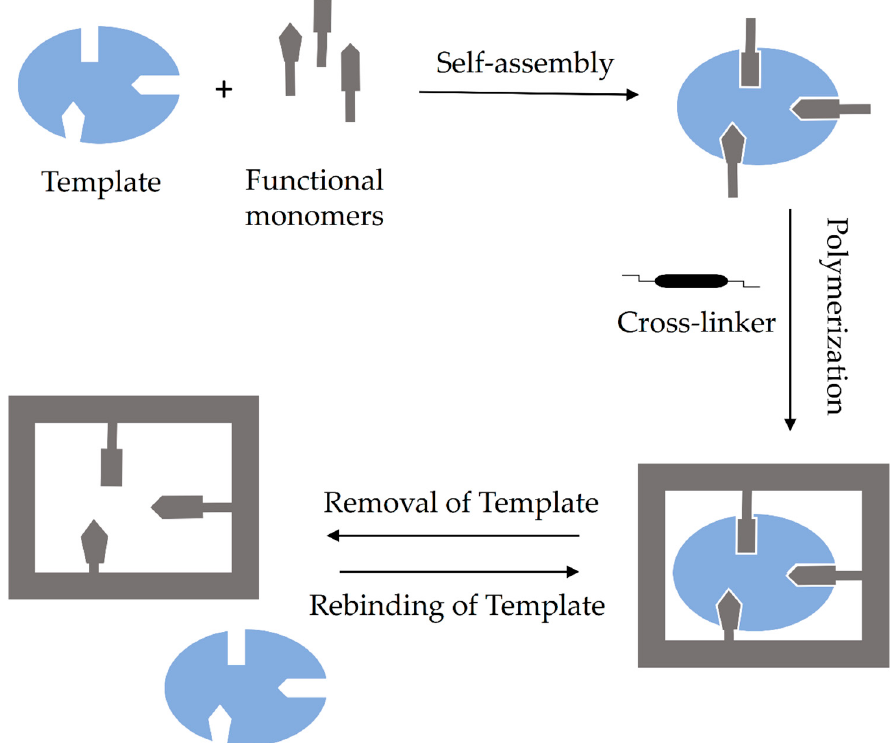
Figure 2. Schematic diagram of the non-covalent method for molecular imprinting process.